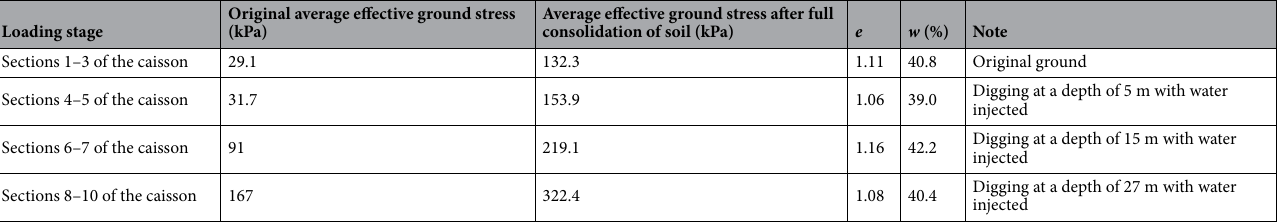
Table 4. Change in water content after dissipation of pore pressure.